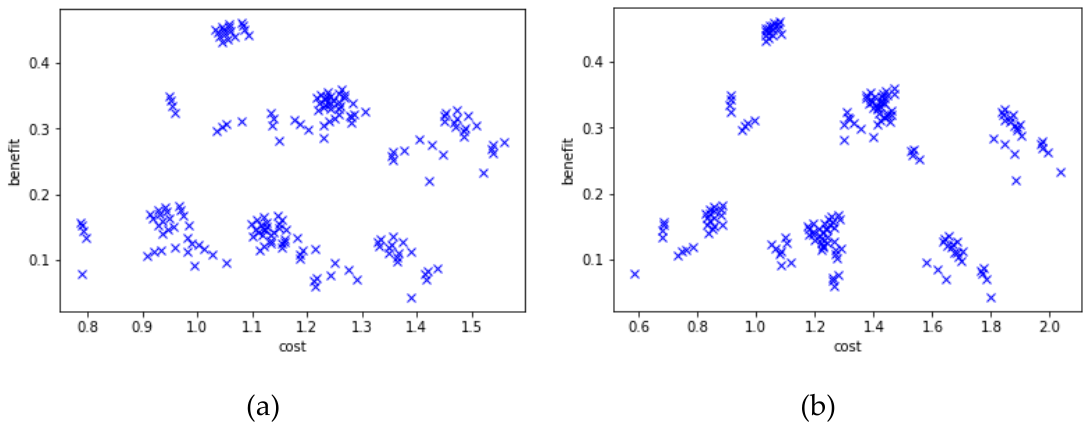
Figure 5. Pre-defined scheme 2 (achieve a carbon neutral district) ( a ) and pre-defined scheme 2A (achieve a carbon neutral district + economic aspects) ( b ).